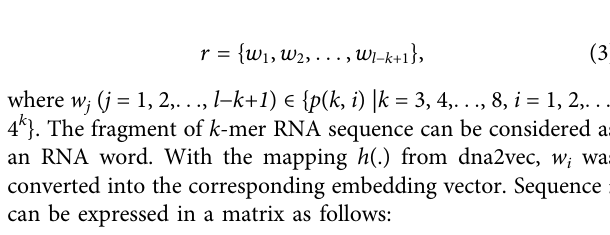
Frontiers in Genetics |